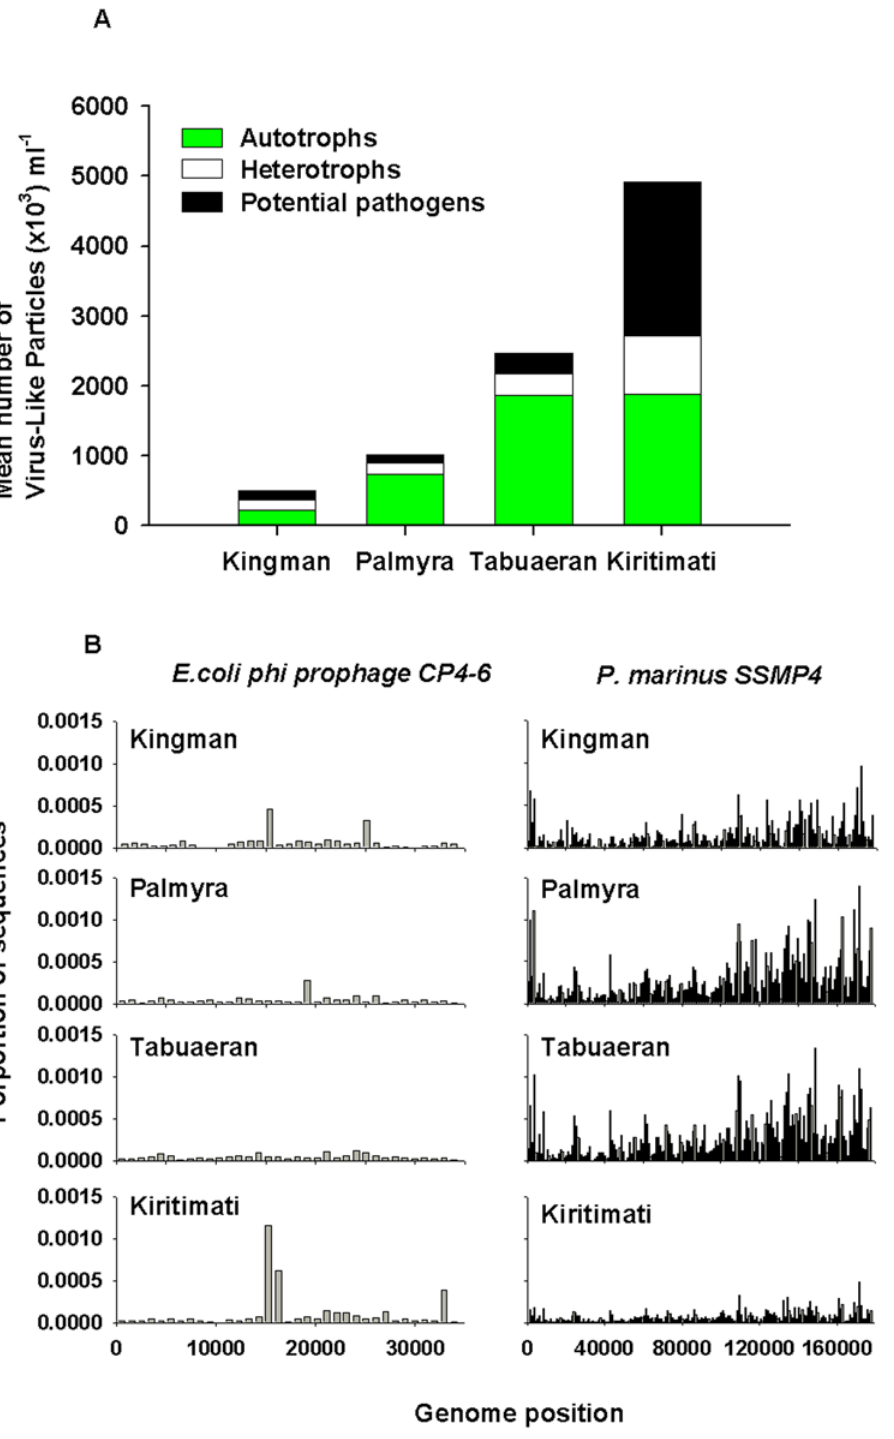
Figure 4. Analysis of the viral metagenomes showing: A) The relative abundances of phage host range by guild. This was the product of the mean number of virus-like particles and the proportion of sequences within the small metagenomic fraction that were similar to autotrophic, heterotrophic or potential pathogenic phage hosts. B) Sequence recruitment across the Escherichia coli W CP4-6 prophage (which is found in highly virulent E. coli ) and Prochlorococcus marinus SSMP4 (which infects an open water autotrophic cyanobacteria). doi:10.1371/journal.pone.0001584.g004 losses. The impact of people on fish communities is uncontrover- quality) vs. global impacts (especially warming and associated sial. The causes of coral loss are also likely to be anthropogenic, bleaching) is more debated. Also Jarvis, an uninhabited island with but the relative importance of local impacts (fishing and water similar oceanographic conditions and global warming conditions